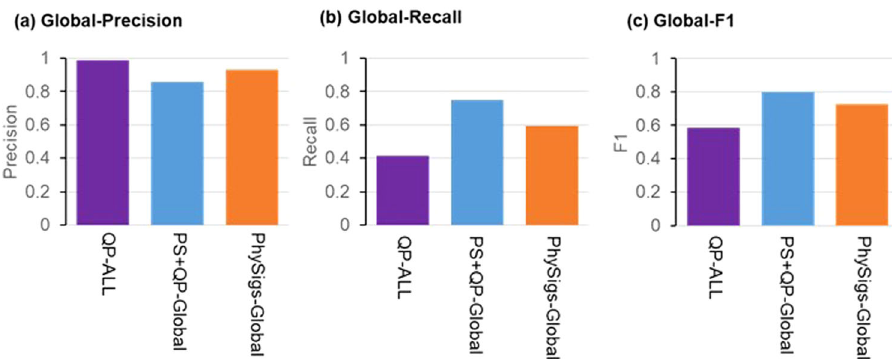
Fig. 5 Detection of signatures for a whole tumor. a Precision, ( b ) recall, and ( c ) F1 score were calculated for the detection of signatures for a whole tumor (an entire phylogeny). For the QP-ALL approach, variants from all phylogeny branches were pooled, and signatures were estimated. For the PS + QP-Global and PhySigs-Global approaches, signatures were detected for each branch and then were